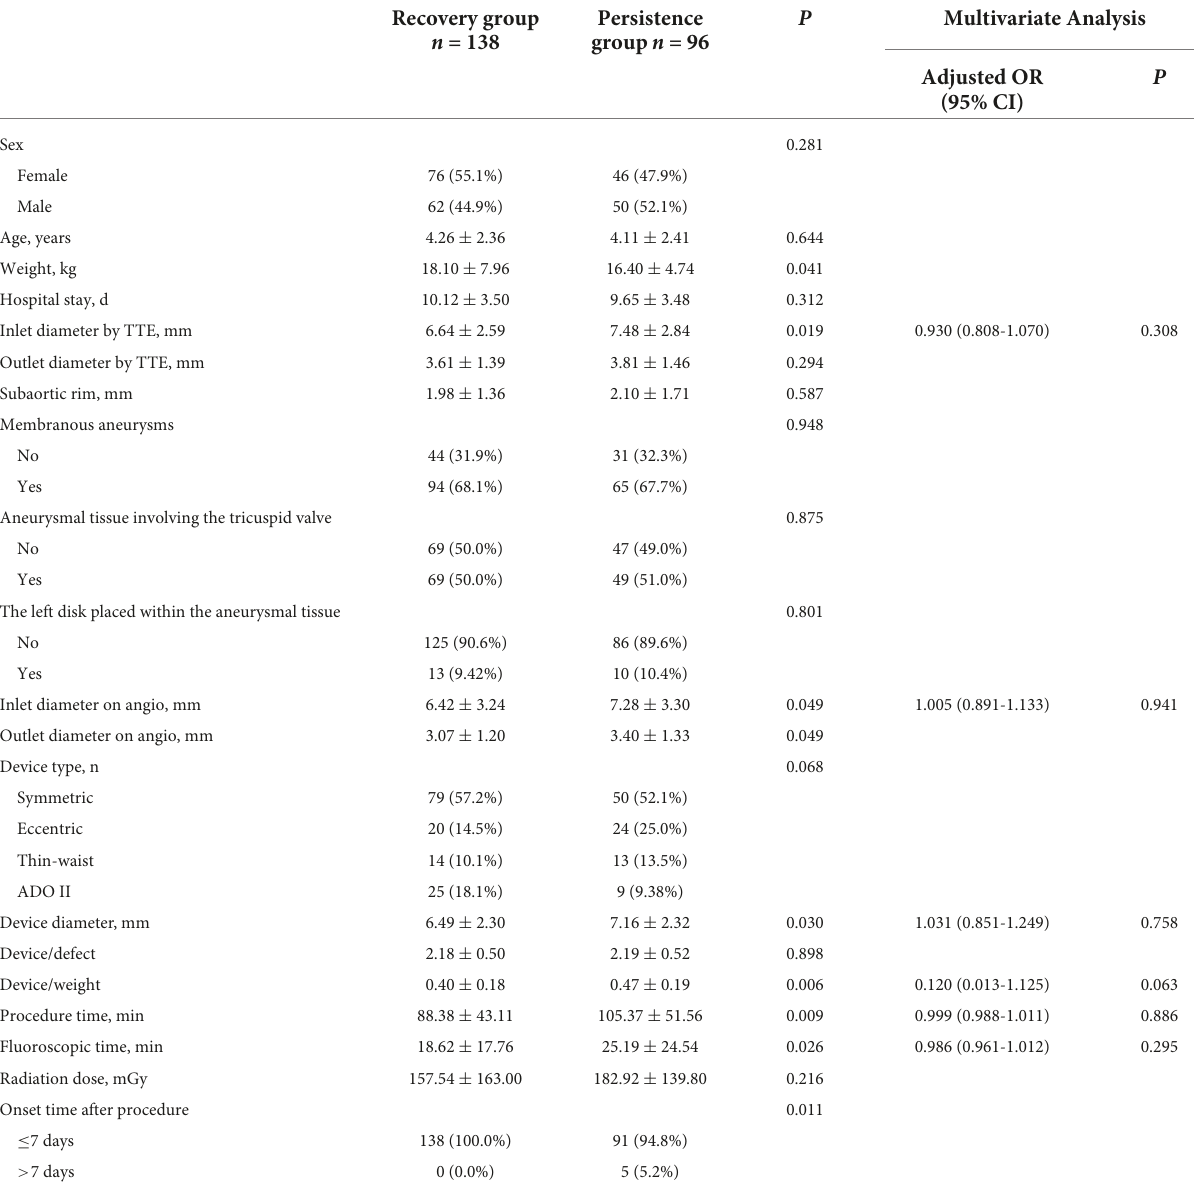
TABLE 10 Risk factors for persistence of heart